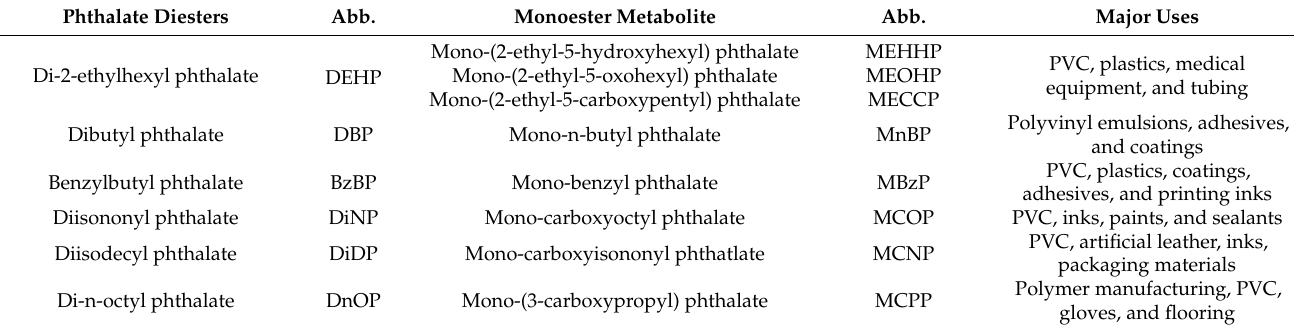
Table 1. Major phthalate diesters and their corresponding metabolites with major uses included in this study. Phthalate Diesters